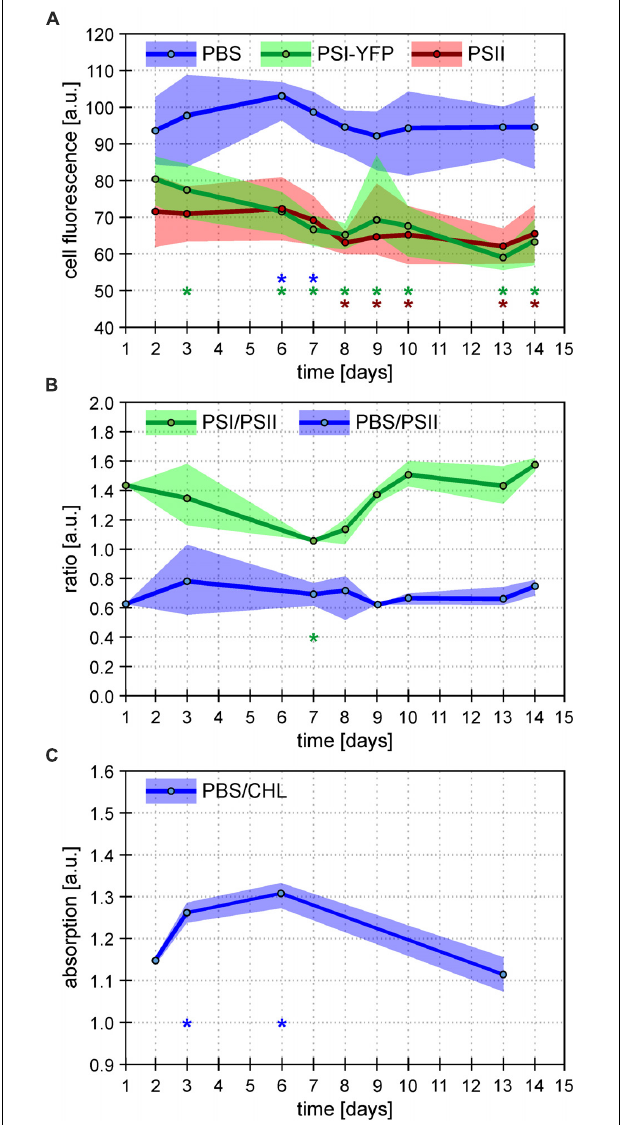
FIGURE 3 | Overall behavior of Synechocystis PSI-YFP cells during cultivation in bioreactor. Figures depict continual acclimation of Synechocystis PSI-YFP cells after their shift from continuous light (day 0) to day–night cycle in bioreactor (days 1–14). (A) Intensity of single-cell fluorescence of pigment–protein complexes calculated from confocal images. Three channels were detected: PSI-YFP (green), PSII (red), and PBS (blue). The day values represent averages from six different time spots per day (see Supplementary Figure 3 for the whole diel cycle), ranges shows variability during the same day (i.e. maximal/minimal values in the day, not SD). Total number of cells analyzed per day was between n = 709 and 1565. Asterisks indicate data points significantly different from corresponding fluorescence value at day 2 ( p < 0.05; blue = PBS; green = PSI-YFP; red = PSII). (B) Bulk measurements of PSI/PSII and PBS/PSII fluorescence ratios measured at 77 K. PSI/PSII fluorescence ratio (green line) reflects ratio of photosystems (excitation at 461 nm, detection at F730/F695 nm). The PBS/PSII fluorescence ratio (blue line) is a measure of PBS decoupling (excitation at 531 nm, detection at F660/ F695 nm). Points represent averaged values per day ( n = 9); ranges show variability during the same day (i.e. maximal/minimal values in the day, not